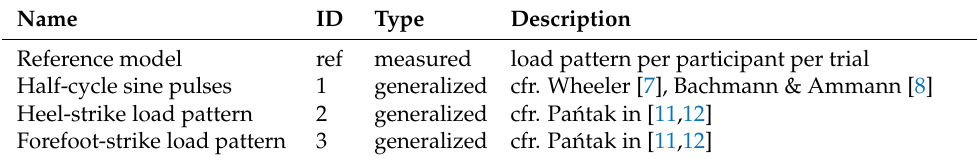
Table 1. The single-step load patterns used in this